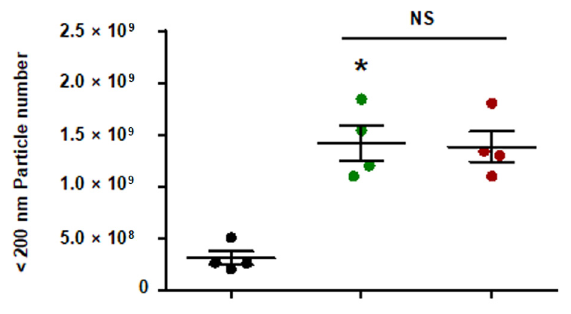
Figure A1. Quantity of EC-sEVs under FSS conditions. HUVECs were cultured under static or FSS conditions for 24 h. Static EC-sEVs (Static-sEVs) or shear stress-induced EC-sEVs (LSS- or OSS-sEVs) were isolated from culture media using ultrafiltration. Quantity of EC-sEVs secreted under FSS conditions were analyzed using NTA. ( n = 4; * p < 0.05 compared to static, NS = no significant). Mean ± SEM. Statistical analysis was performed using the nonparametric Mann–Whitney U test.